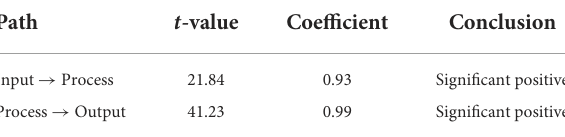
TABLE 2 Results of structural model analysis. Path t -value Coefficient Conclusion